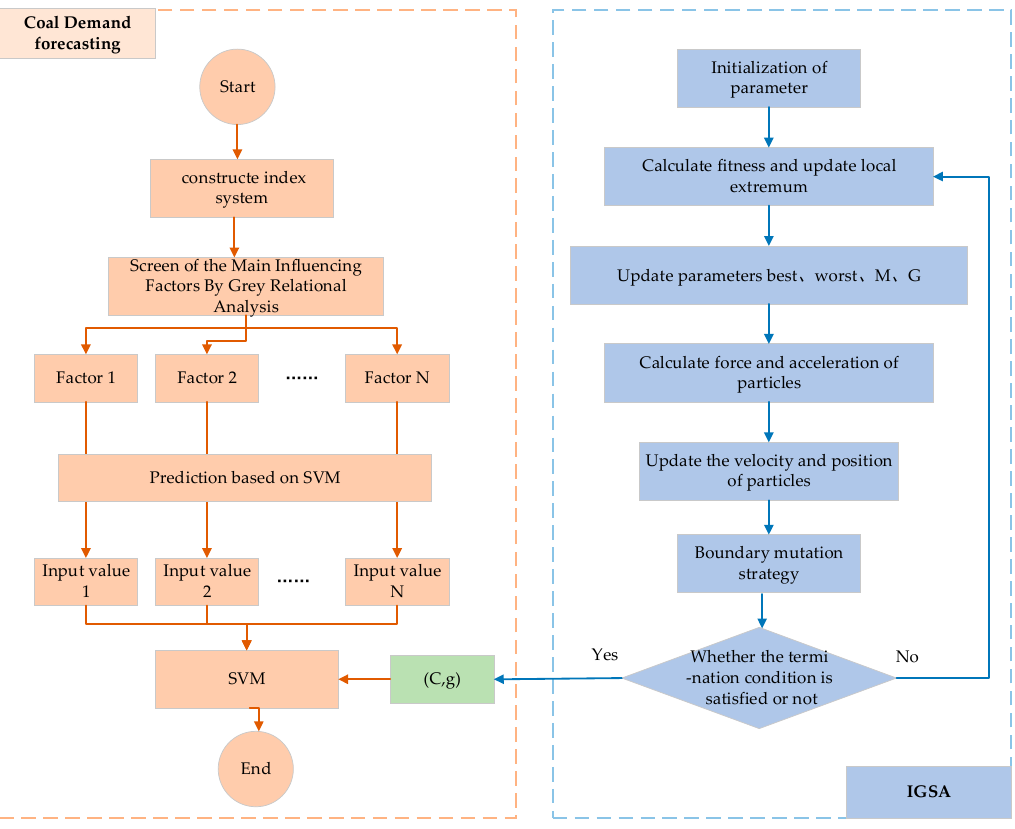
Figure 3. The flow chart of forecasting.